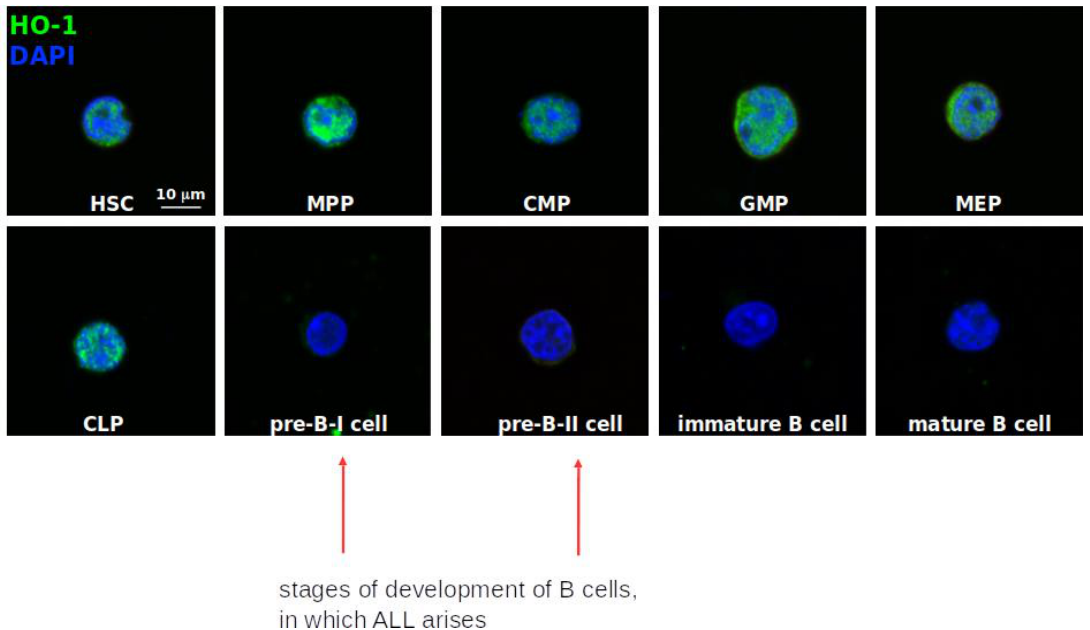
Figure 6. Confocal microscopy slides displaying HO-1 protein (green) and nuclear staining (blue) in normal bone marrow hematopoietic stem and myeloid progenitor cells, as well as B-cell developmental stages. HSC—hematopoietic stem cells, MPP—multipotent progenitors, CMP—common myeloid progenitors, GMP—granulocyte-macrophage progenitor, MEP—megakaryocyte-erythroid progenitor, CLP—common lymphoid progenitor.